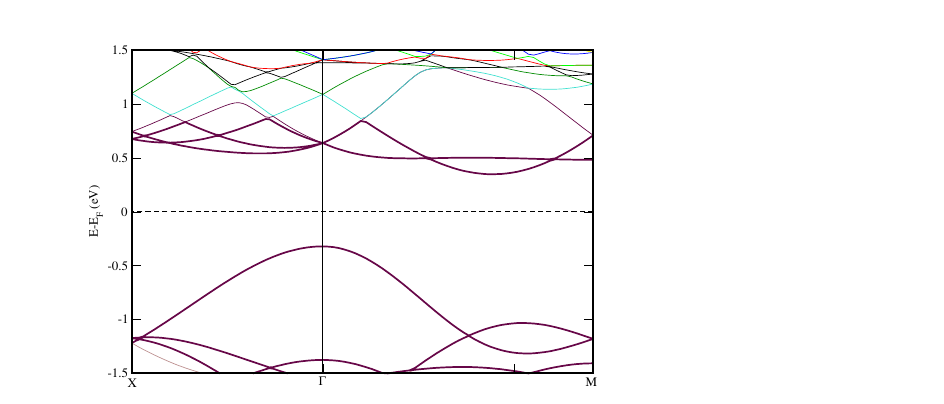
Figure 5. Electronic band structure of MoS 2 Monolayer with cubic confinement. Horizontal dashed line implies the E f set to zero energy at